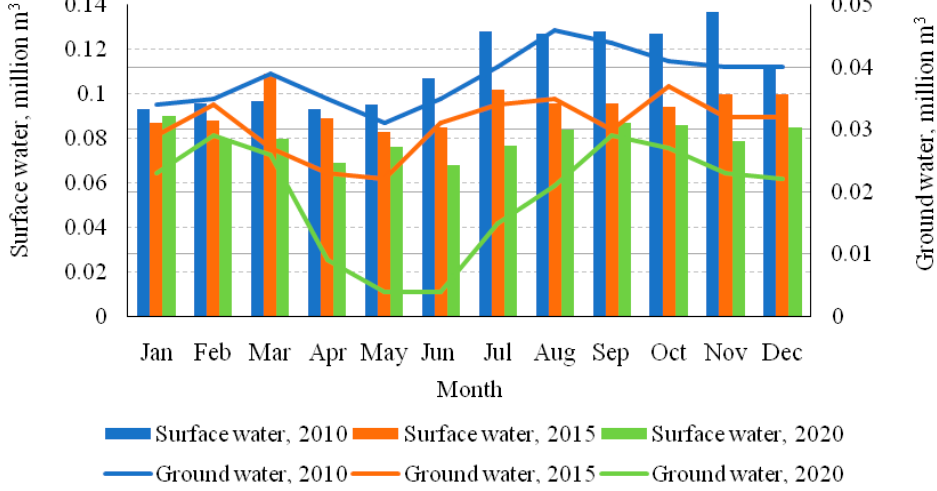
Figure 4. Dynamics of monthly water abstraction from surface water (the Southern Bug River) and deeper groundwater (wells) for Khmilnyk’s drinking water deeper groundwater (wells) for Khmilnyk’s drinking water supply.